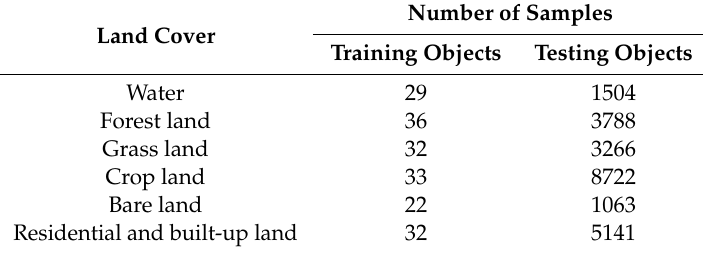
Table 2. Samples of six land cover categories for feature selection and sample augmentation